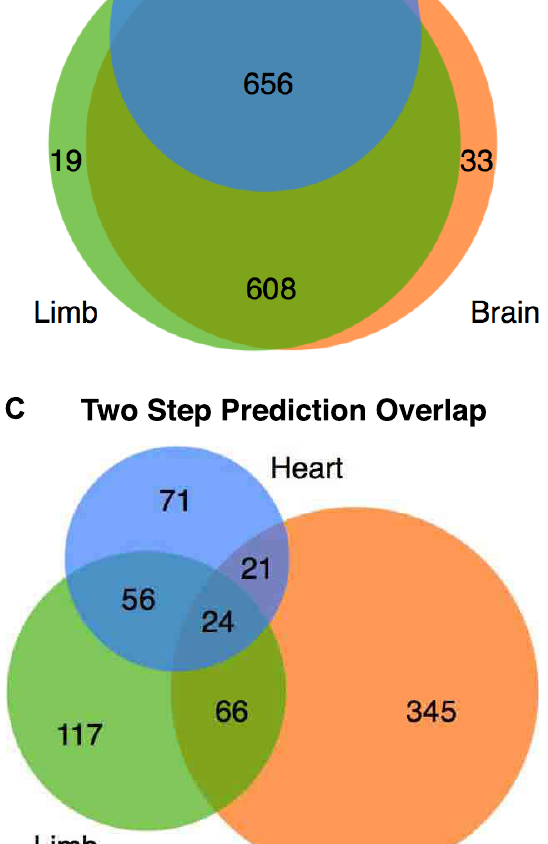
Figure 5. EnhancerFinder’s two-step approach captures tissue- specific attributes of enhancers. (A) The true overlap of human enhancers of brain, heart, and limb in the VISTA database. The vast majority of characterized enhancers are unique to one of these tissues at this stage. For example, of the 84 validated heart enhancers, 71 are unique to heart, five are shared with brain, four with limb, and four with both. (B) The predicted overlap of VISTA enhancers based on predictions made with a single training step using MKL with only enhancers of that tissue considered positives and the genomic background as negatives. This approach overestimates the number of enhancers active in multiple tissues. Each classifier mainly learns general attributes of enhancers, rather than tissue-specific attributes. (C) The predicted overlap based on EnhancerFinder’s two-step approach. These predictions are much more tissue-specific and exhibit overlaps between tissues similar to the true values (A). Predicted tissue distributions are similar when the methods are applied to other genomic regions, as illustrated in our genome-wide predictions, but only predictions on VISTA enhancers are shown here to enable comparisons to the distribution for validated enhancers